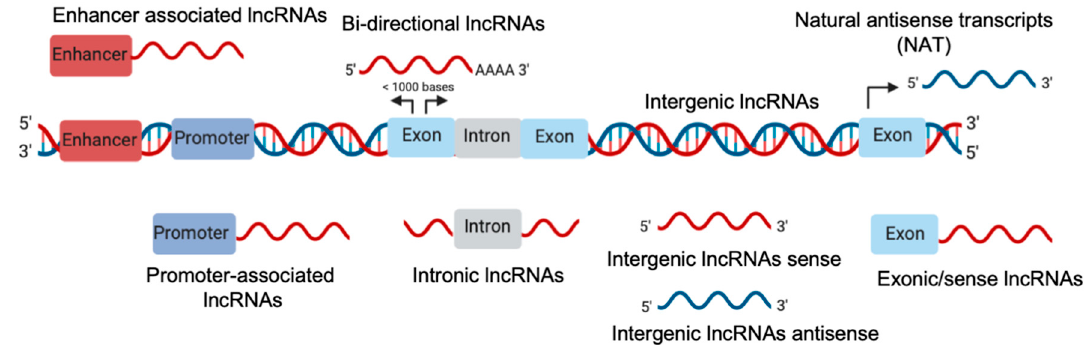
Figure 1. Schematic representation of long noncoding (lnc)RNA biogenesis.